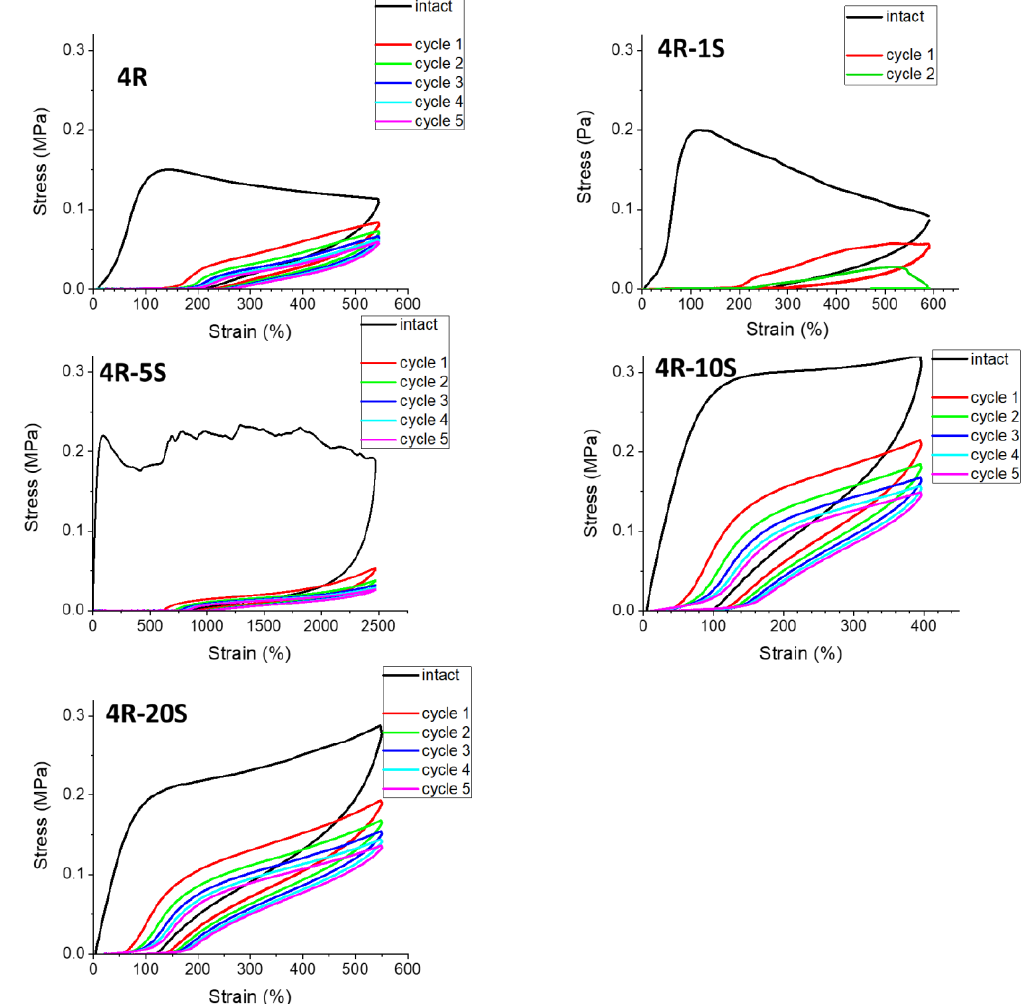
Figure 13. Effect of SMA co-monomer content in the matrix (0, 1, 5, 10, and 20 mol%), demonstrated on the example of nanocomposites filled with 4 wt.% of clay: Repeated cyclic loading tests.